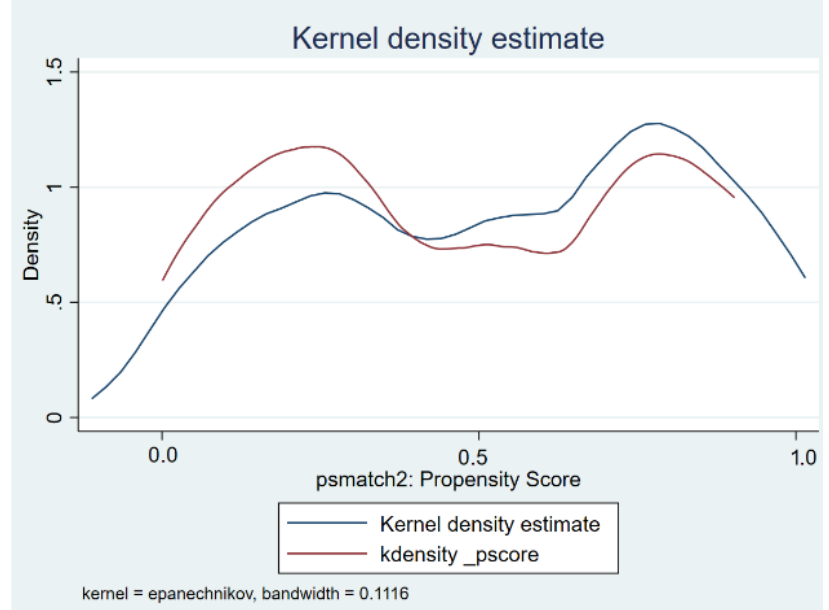
Figure 2. Probability density before matching.